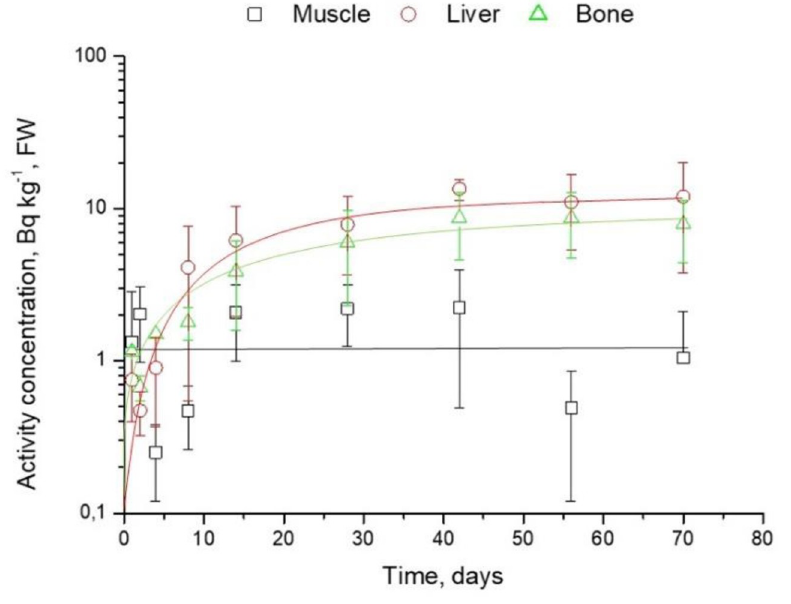
Fig 2. Mean ( ± SD) activity concentrations of 241 Am in the organs of broilers Group 1 (n = 27) during long term intake, Bq kg -1 ,FW.